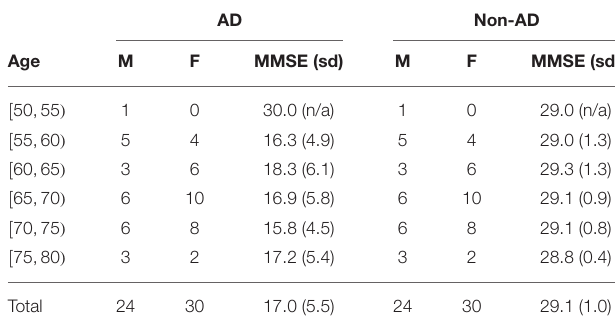
TABLE 1 | Basic characteristics of the patients in each group in the ADReSS challenge dataset are more balanced in comparison to DementiaBank. Dataset